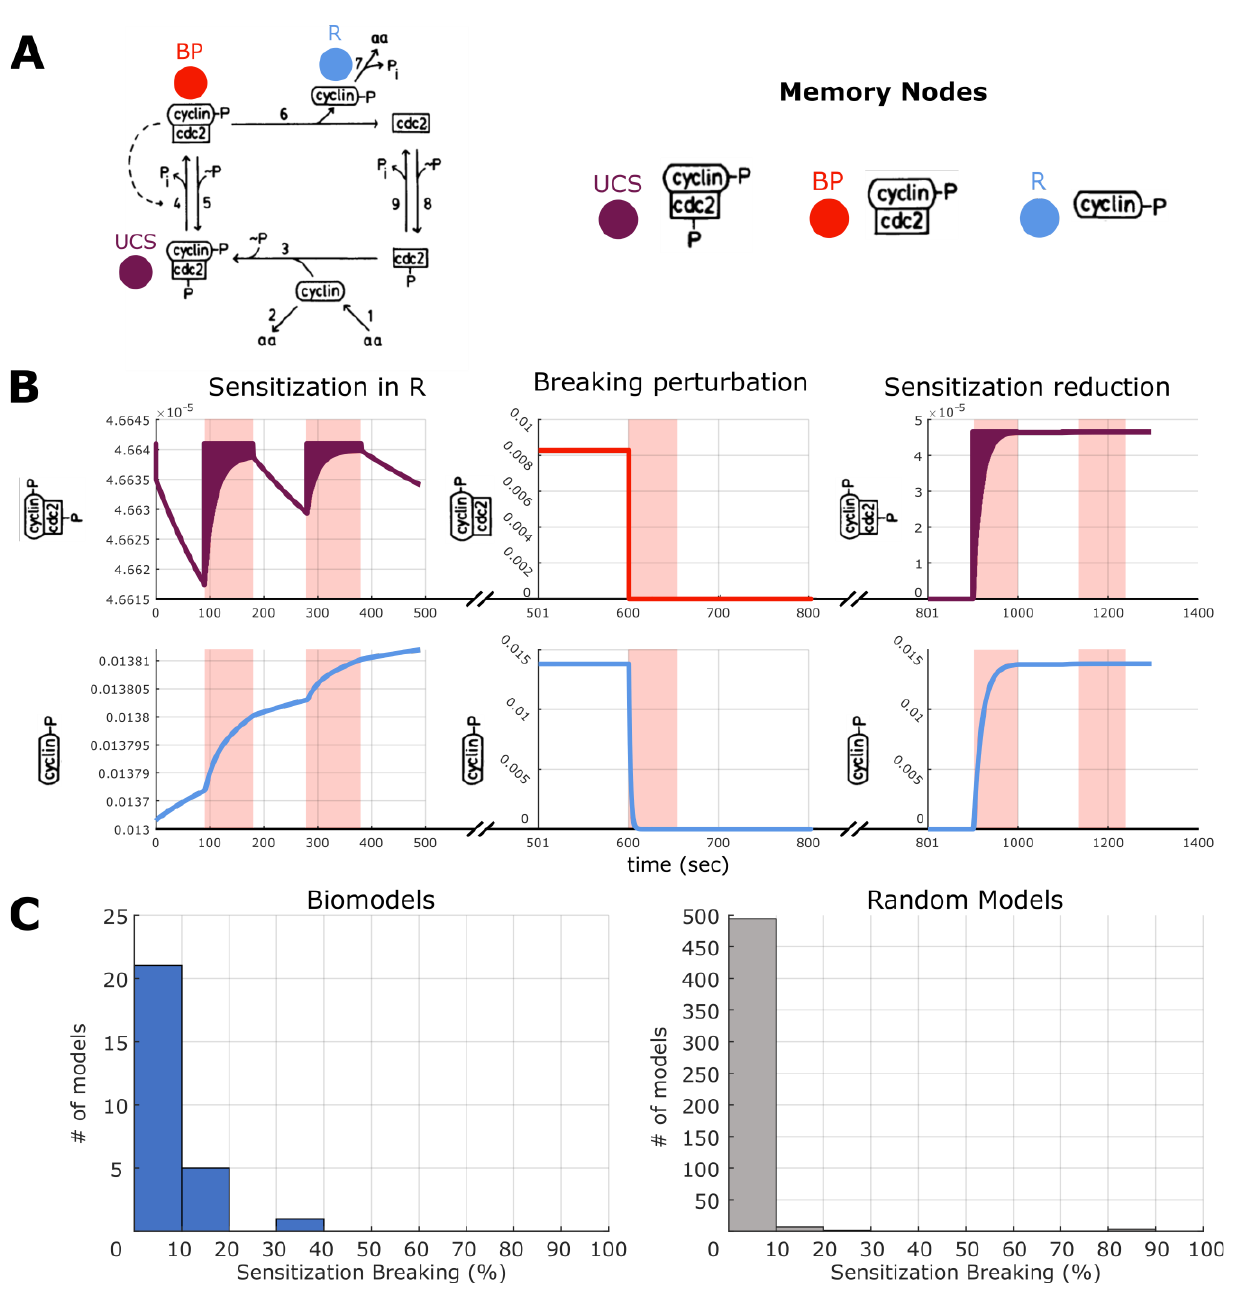
Figure 11. Breaking sensitization. ( A ) An example potential memory model build from the biological model in [77] that shows both sensitization to stimulation as well as breaking of that sensitization through an alternative stimulation, a breaking perturbation (PB). ( B ) Time courses showing habituation (left), stimulation on the BP node (middle), and the subsequent sensitization breaking (right). All graphs are a part of the same simulation and separated for visualization only. Red shaded areas indicate when a stimulation was delivered, either on the UCS or BP node. ( C ) Distribution of sensitization breaking across all biological models and random networks. The x -axis is measured as the percentage of memory models for a given biological model that show sensitization breaking. We performed a Wilcoxon rank sum test applicable to un-equal samples to test the similarity of the distributions and they are significantly different ( p = 2.17 × 10 −4 5 ).